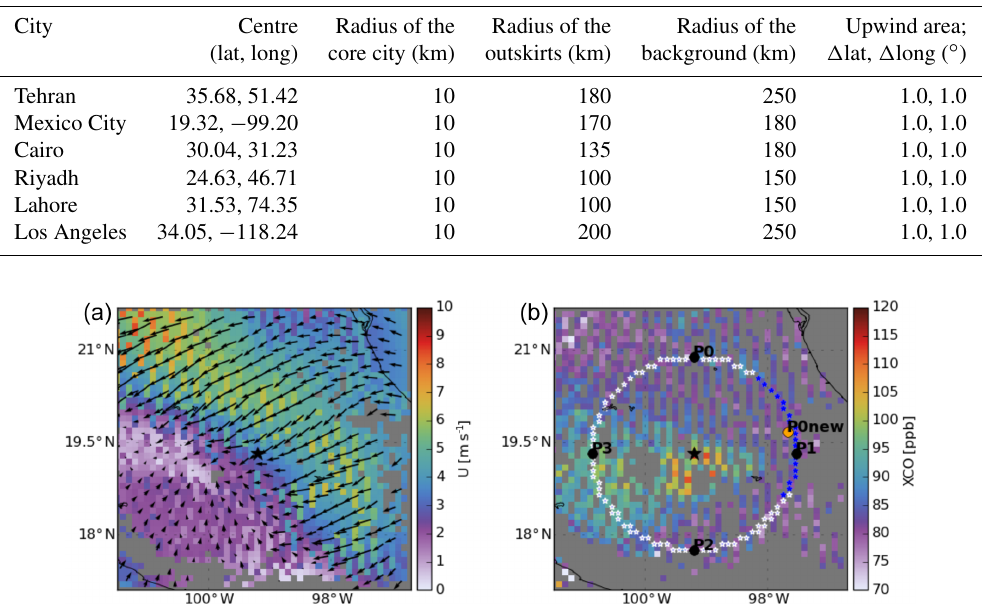
Table 1. Selected megacities and specifications used for emission ratio quantification.